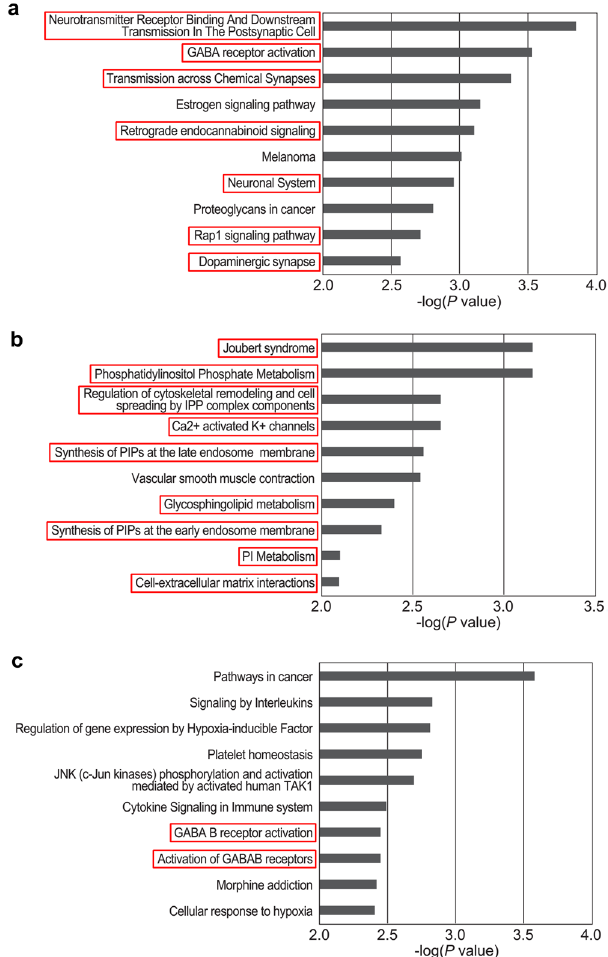
Figure 5. Pathway analysis of candidate miRNA targets. The ten most relevant pathways of the targets of miR-218a-5p ( a ), 219a-5p ( b ), and 221-3p ( c ) are shown. The pathways supposed to be related with vestibular compensation were highlighted with red